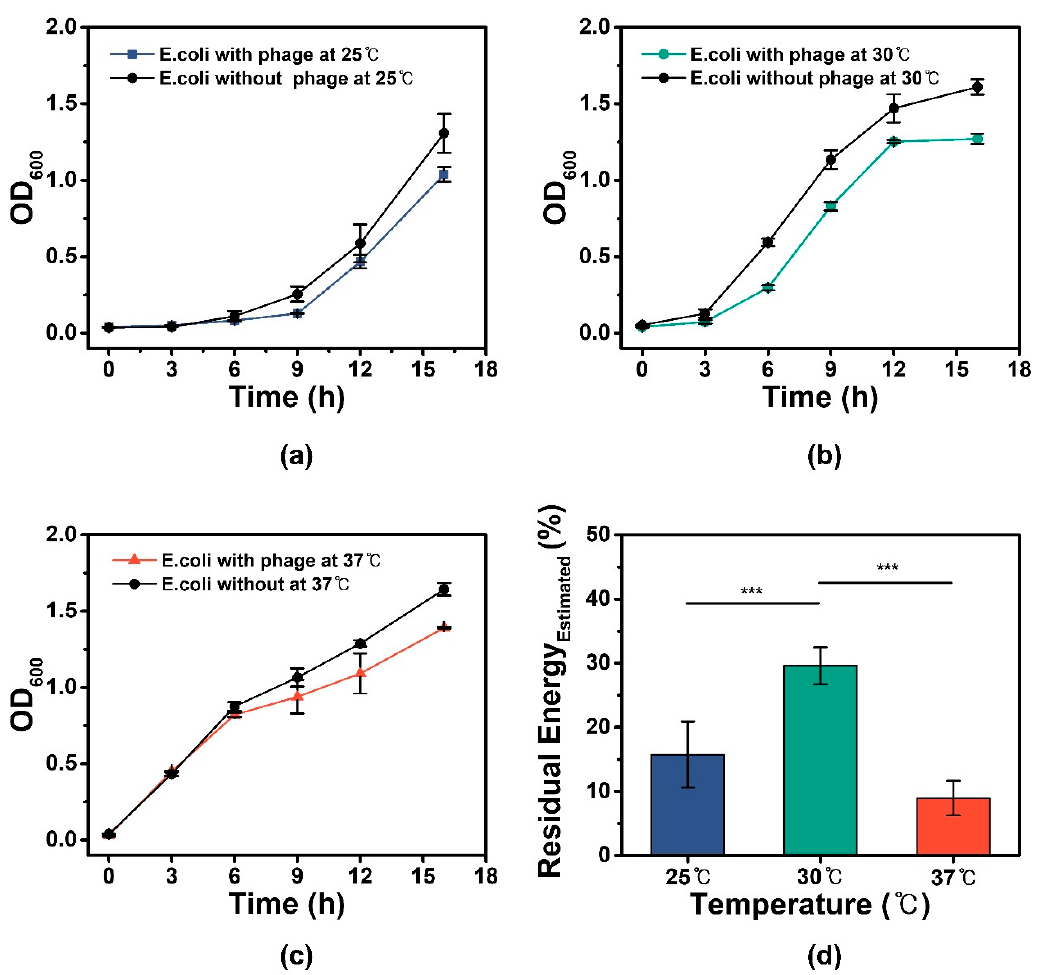
Figure 2. Growth curves and residual energy estimations of E. coli fermented with and without phage infection. Fermentation was conducted with the following conditions: 220 rpm stirring speed, 3 lpm of air injection, and 16 h fermentation term at each culture temperature (25 ◦ C, 30 ◦ C, and 37 ◦ C). The OD 600 of XL1-Blue E. coli fermented with and without phage infection was measured through UV-vis spectroscopy at each culture temperature. Contrasts between OD 600 of E. coli produced with and without phage under the same conditions at ( a ) 25 ◦ C, ( b ) 30 ◦ C, and ( c ) 37 ◦ C culture temperature. ( d ) Percentage of estimated residual energy at each culture temperature was obtained as mentioned in the main text, with the highest percentage at 30 ◦ C culture temperature and 25 ◦ C and 37 ◦ C. n = 3 for each data point. *** p <